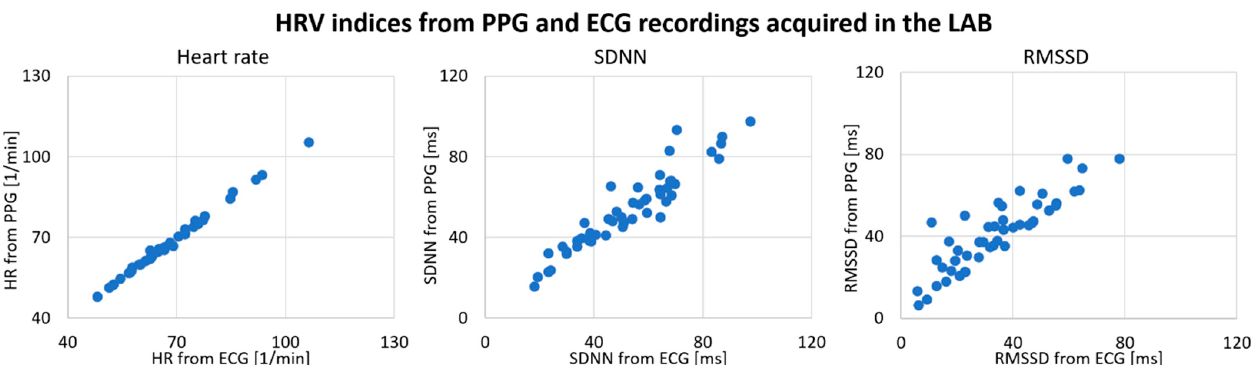
Figure 2. Comparison of HRV from photoplethysmogram and electrocardiogram recorded simultaneously in the laboratory (N = 55). HR: mean heart rate; SDNN: standard deviation of heart beat intervals; RMSSD: root mean square of successive heart beat intervals; ECG: HRV derived from an electrocardiogram recorded in the laboratory; PPG: HRV derived from a photoplethysmogram recorded in the laboratory.